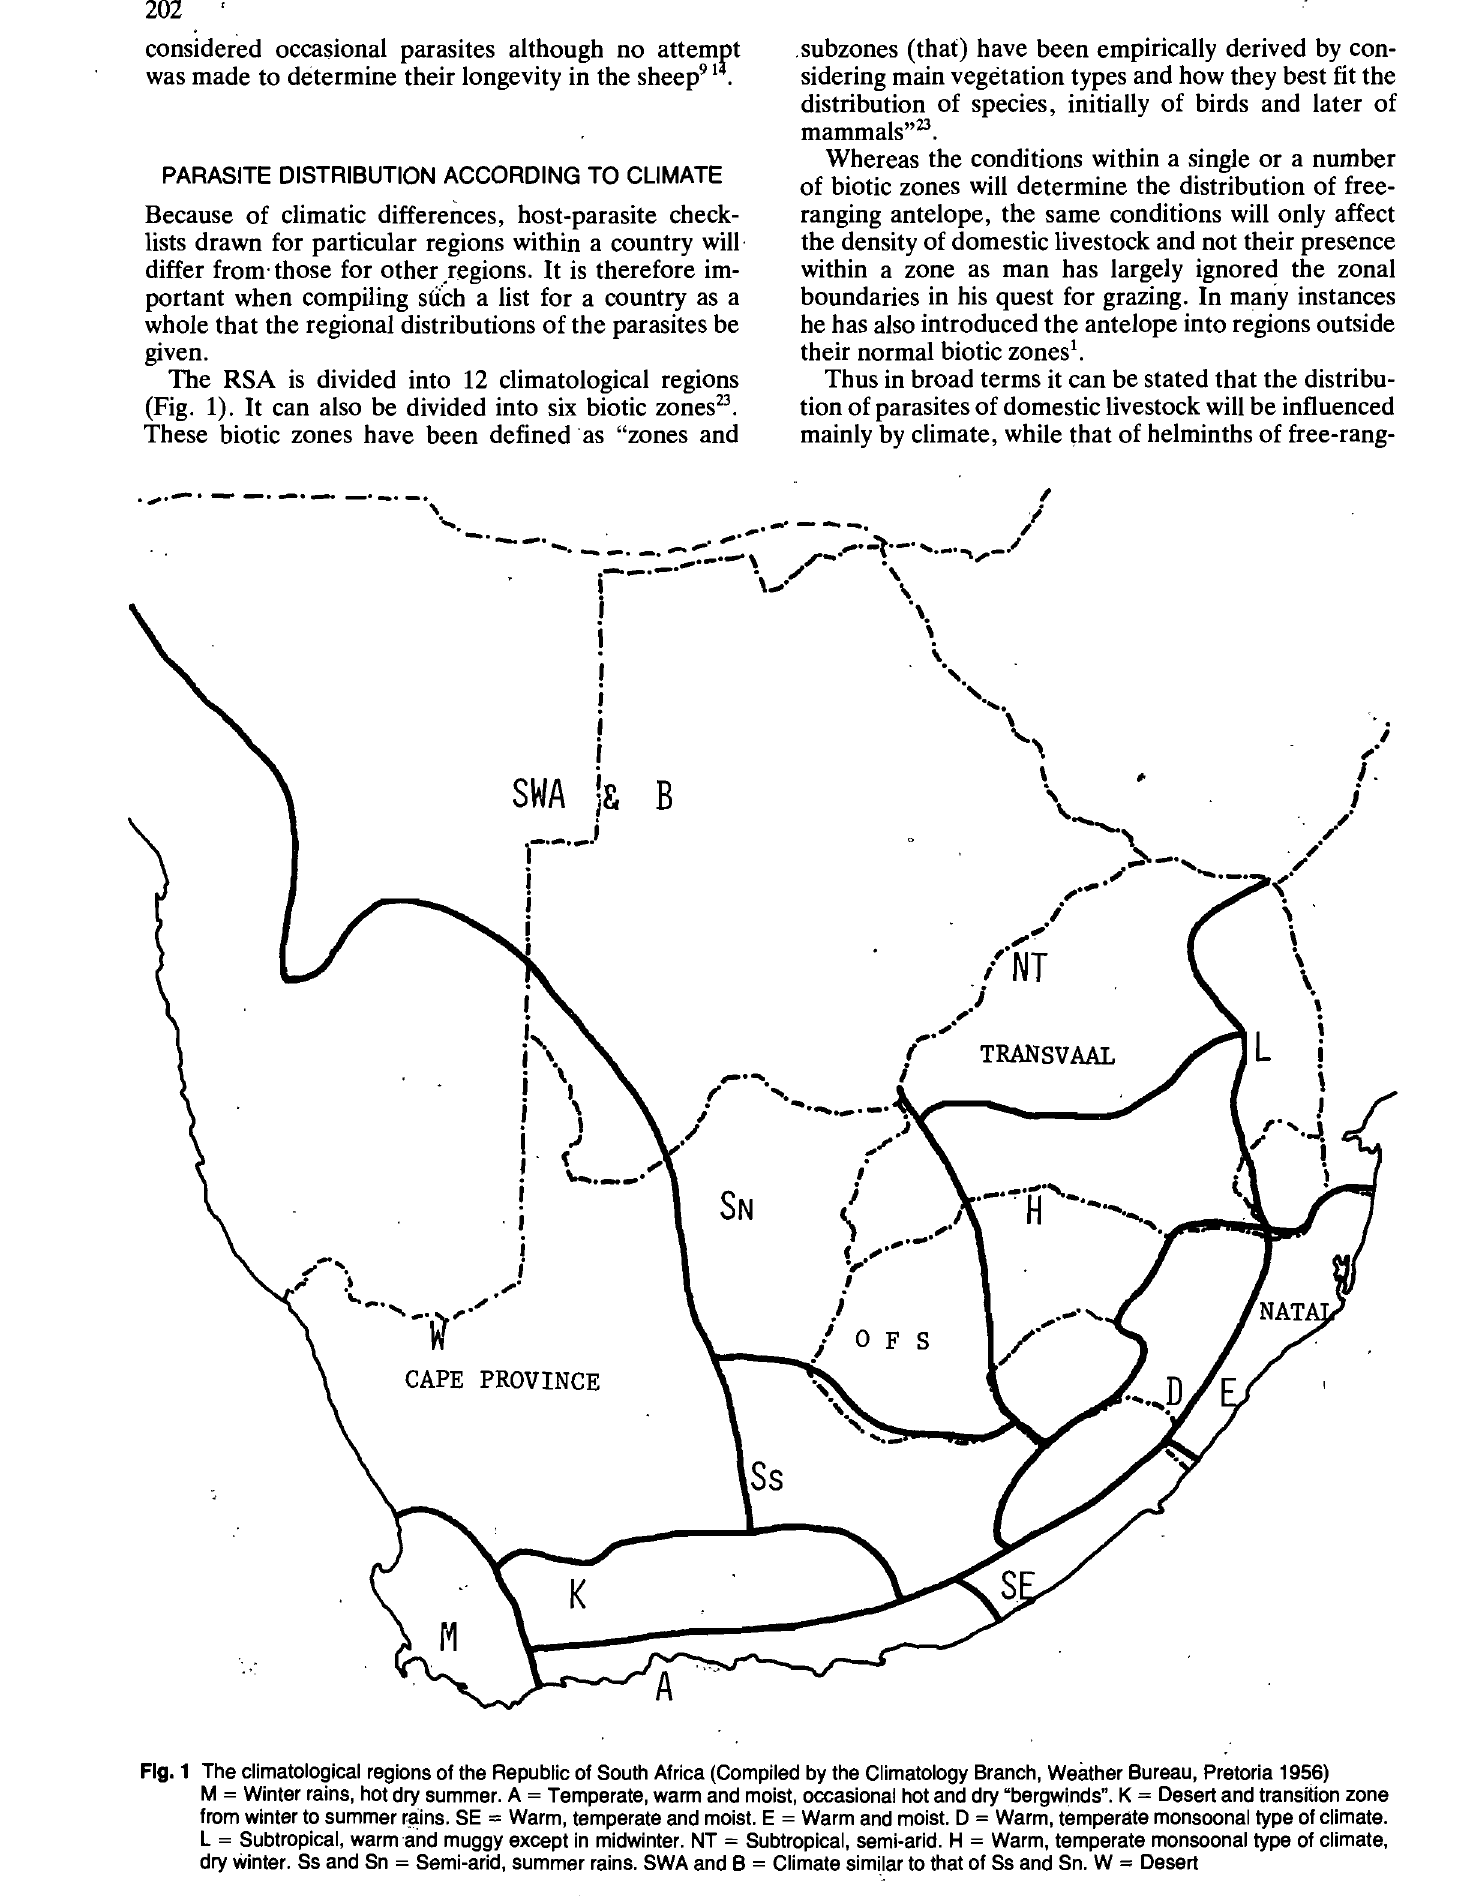
Fig. 1 The climatological regions of the Republic of South Africa (Compiled by the Climatology Branch, Weather Bureau, Pretoria 1956) M = Winter rains, hot dry summer. A = Temperate, warm and moist, occasional hot and dry "bergwinds". K = Desert and transition zone from winter to summer r~ins. SE = Warm, temperate and moist. E = Warm and moist. D = Warm, temperate monsoonal type of climate. L = Subtropical, warm and muggy except in midwinter. NT = Subtropical, semi-arid. H = Warm, temperate monsoonal type of climate, dry winter. Ss and Sn = Semi-arid, summer rains. SWA and B = Climate simUar to that of Ss and Sn. W = Desert